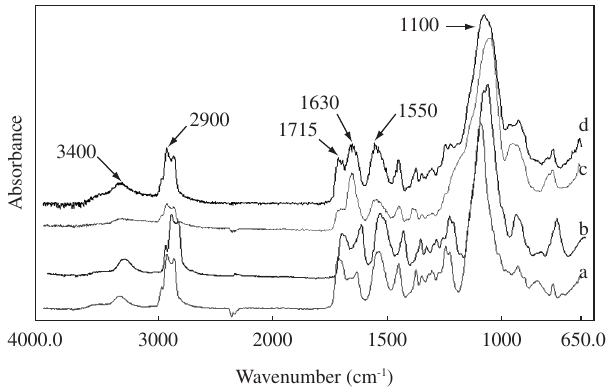
Figure 7. C2 FTIR spectra subtracted from the spectrum of PU-2: a) C2-A; b) C2-B; c) C2-C; d) C2-D; and e)